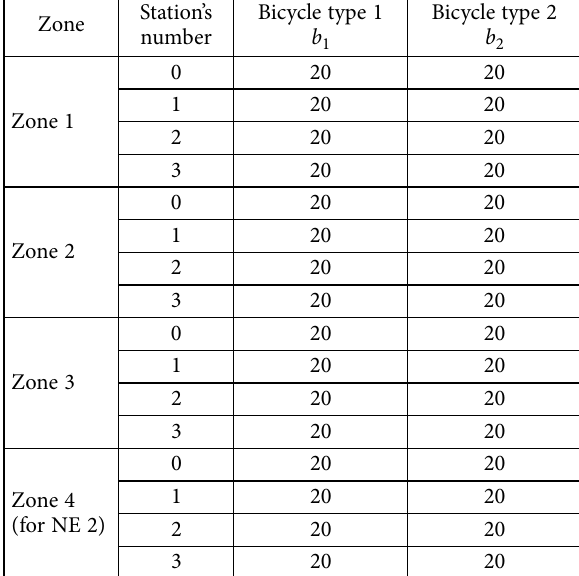
Table 9. Capacity of stations for each bicycle type for both numerical examples